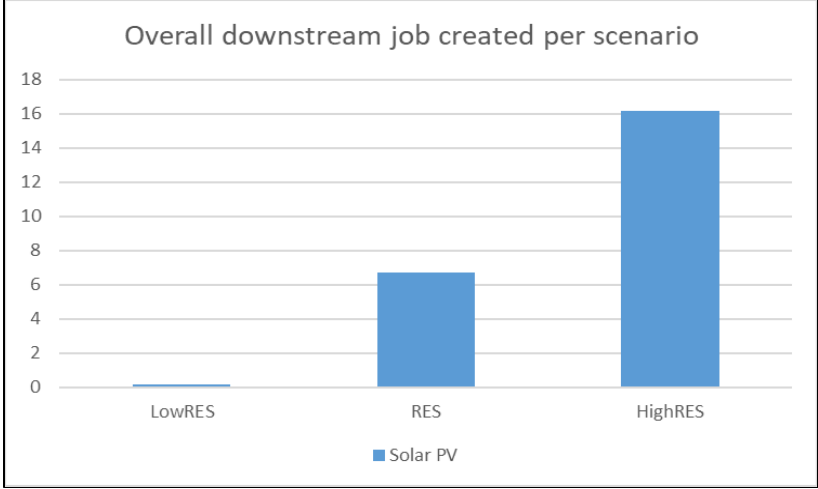
Figure 10. Overall downstream job position creation per scenario for Procida Municipality.